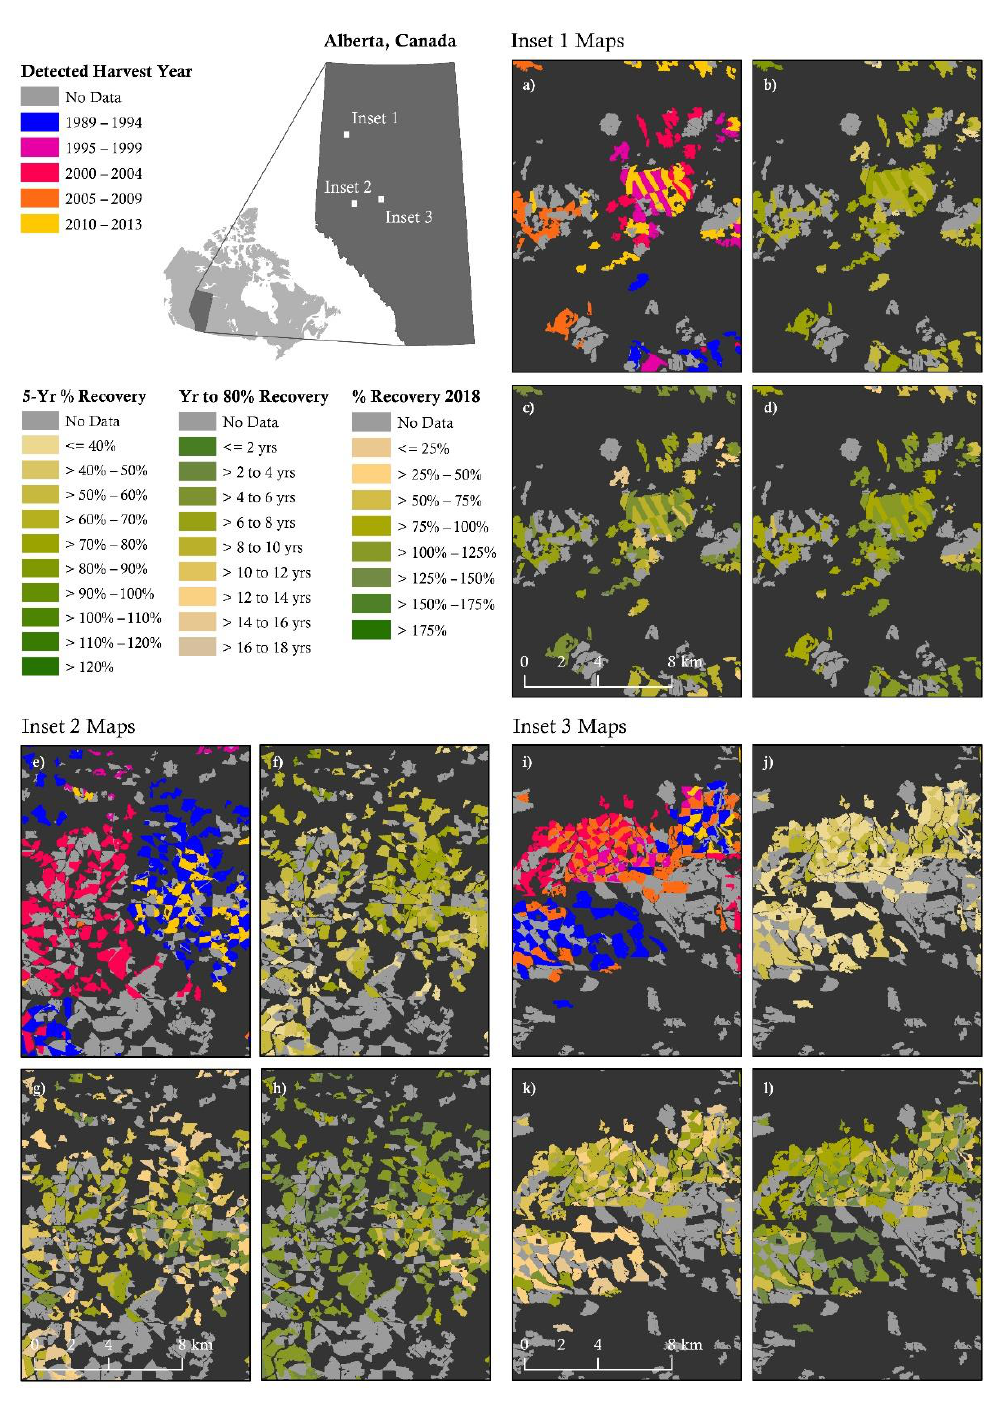
Figure 4. Inset maps showing Harvest yr ( a , e , i ), Recov% 5yr ( b , f , j ), Y2R ( c , g , k ), and Recov% endTS ( d , h , l ) over three subsections of Alberta.